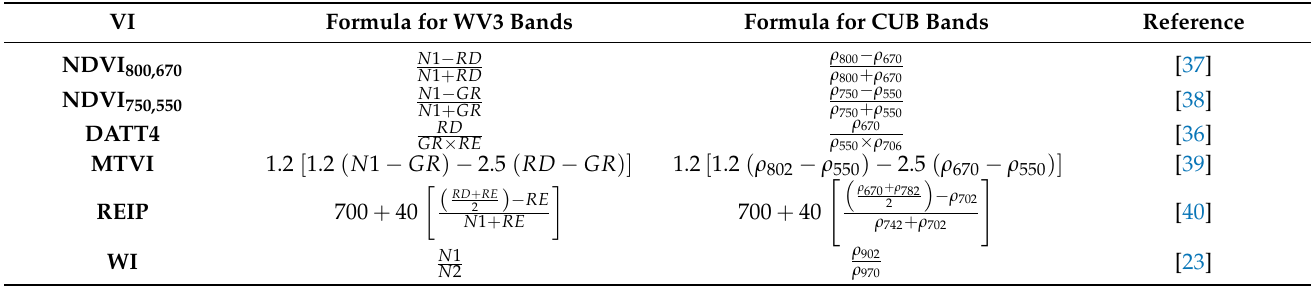
Table 3. Vegetation indices (VI) and their equations for WordView-3 (WV3) and Cubert (CUB) images. WV3 band names: GR: green, RD: red, RE: red-edge, N1: near-infrared 1. CUB bands are indicated by wavelength ( ρ xxx ) in nanometres. (NDVI: normalised difference vegetation index, DATT4: The 4th VI introduced by [36], MTVI: modified triangular vegetation index, REIP: red-edge inflexion point, and WI: water index)